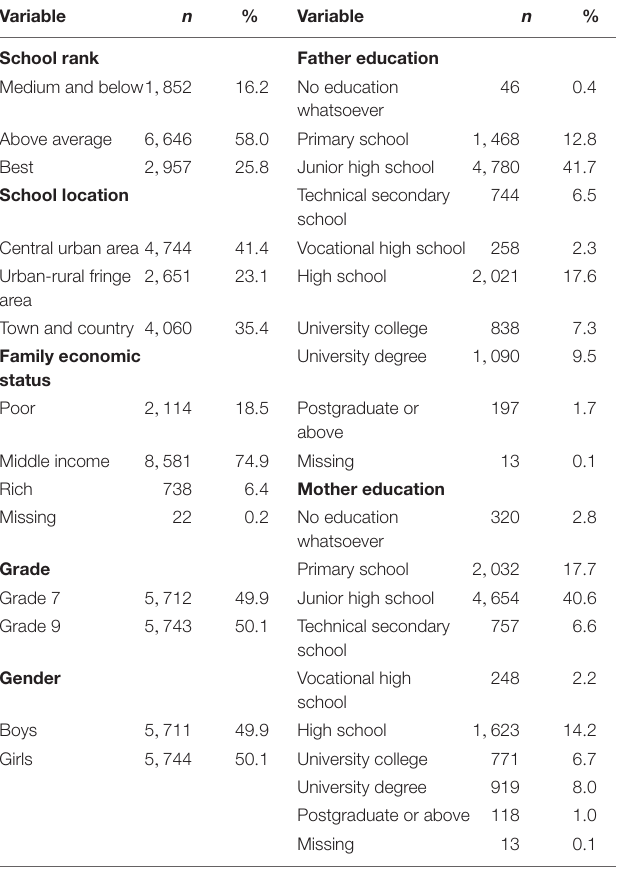
TABLE 1 | Sample distribution of school rank, school location, family economic status, grade, gender, and father and mother education. Variable n